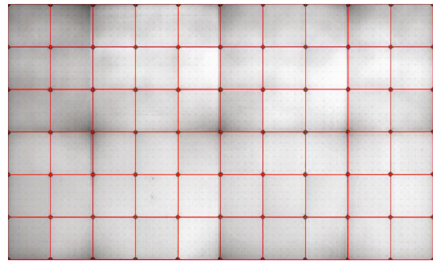
Figure 8: Boundary positioning of silicon wafer